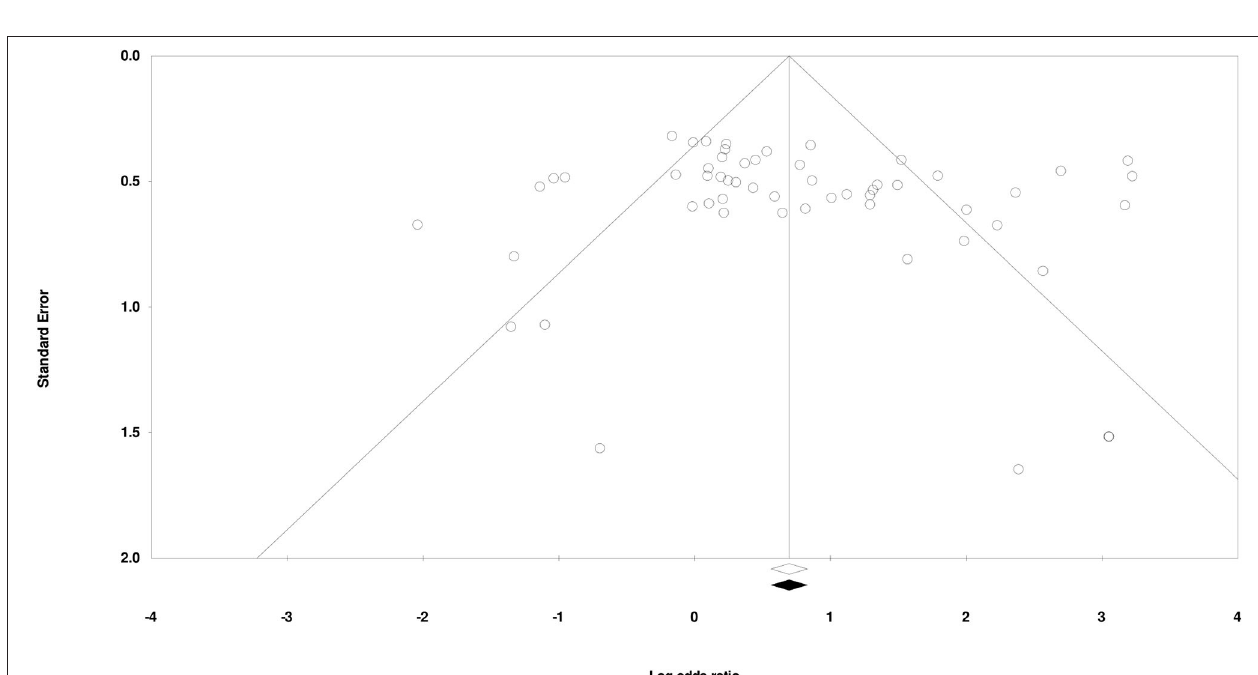
FIGURE 2 | Risk of bias according to the Cochrane risk of bias assessment for the randomized controlled trials.